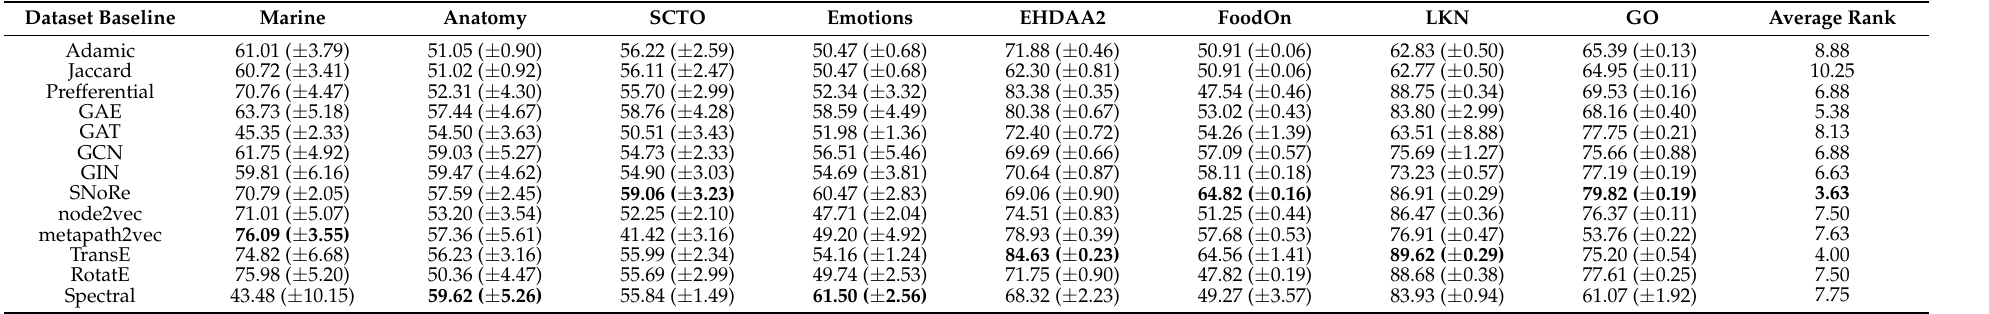
Table 3. Link prediction results based on the ROC-AUC metric (multiplied by 100 to improve readability) and average rank. Dataset